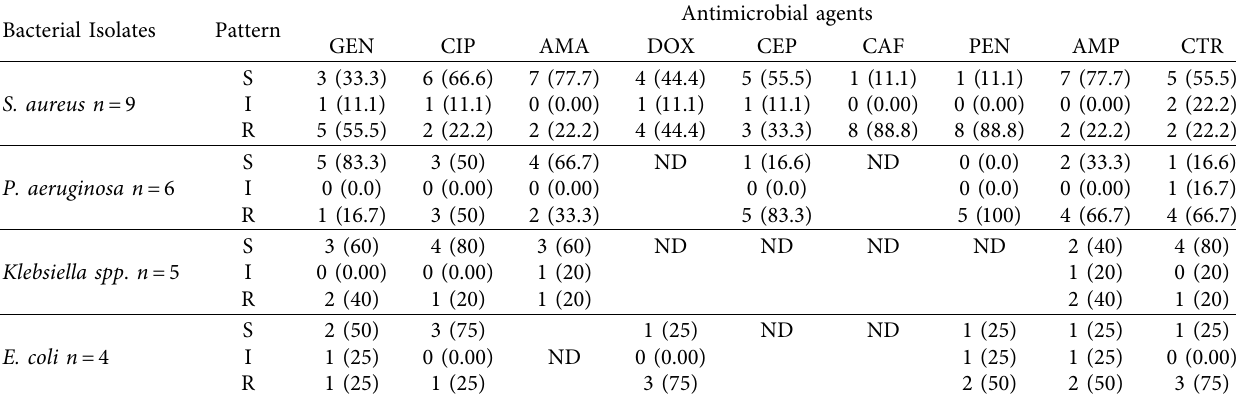
Antimicrobial agents